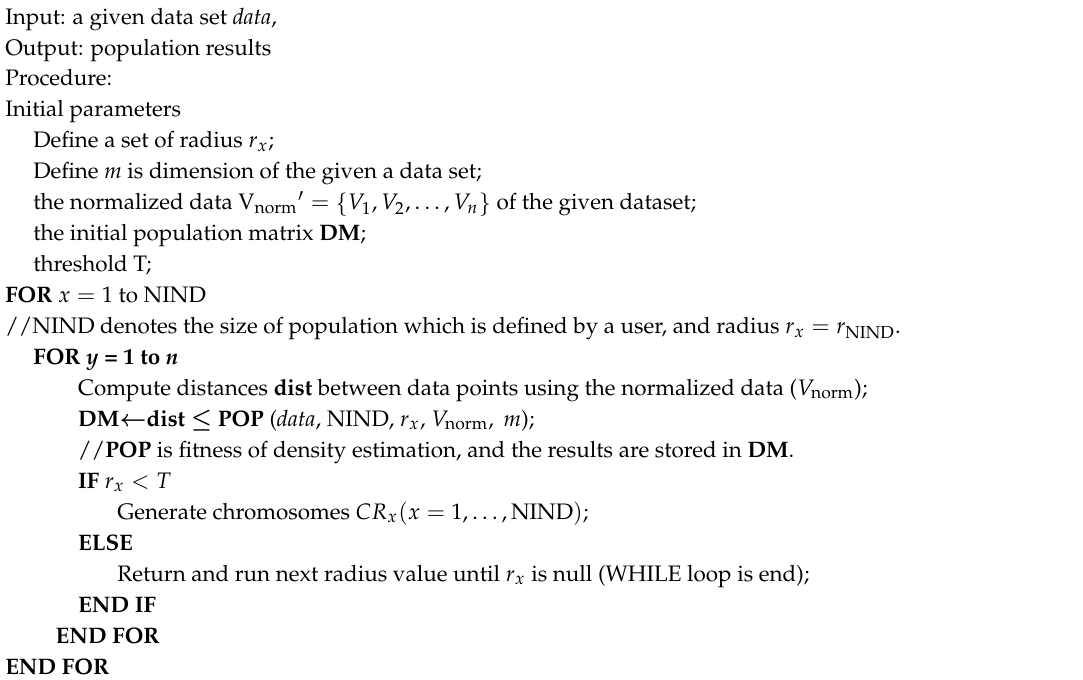
Algorithm 1. Population generation using density estimation